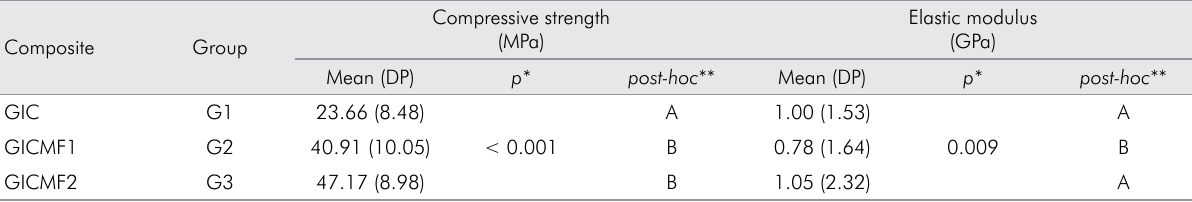
Table 1. Mean and standard deviation values of the compressive strength and elastic modulus, and their statistical significances.